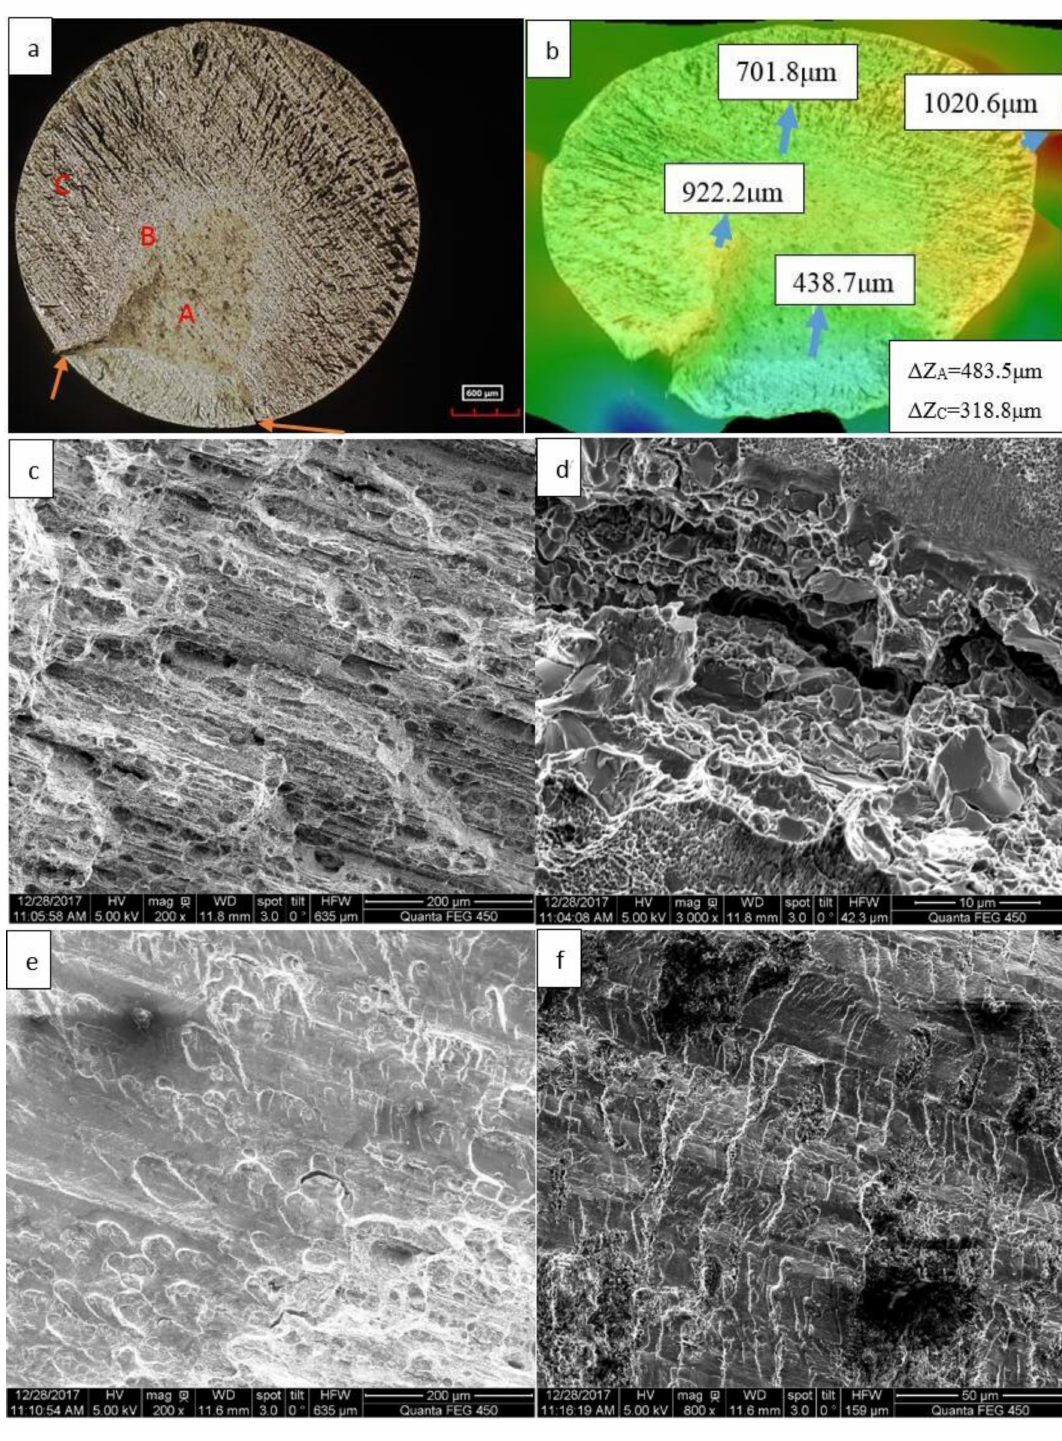
Figure 6. Fatigue fracture surface of N f = 3.52 × 10 4 , σ = 113.3 MPa in air for the uncoated sample. ( a ) Macro-scale view of the fracture surface; ( b ) Three-dimensional view of the fracture surface; ( c , d ) region labeled A; ( e ) region labeled B; ( f ) region labeled